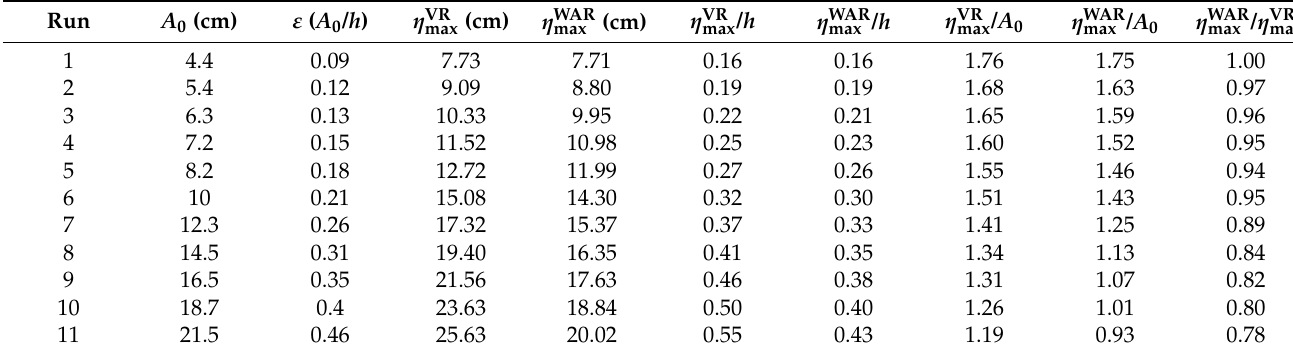
Table A1. Maximum overtopping heights at the front of vertical wall